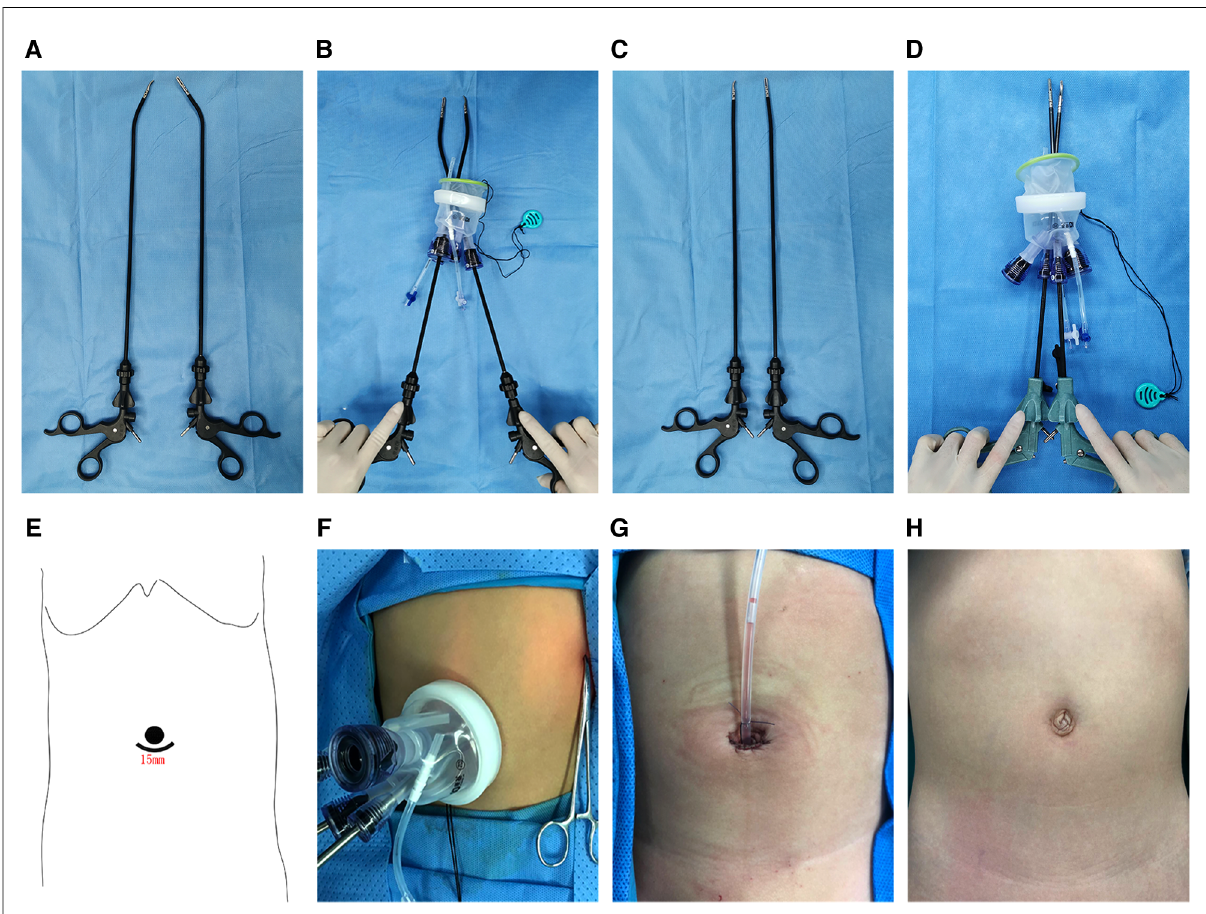
FIGURE 3 Surgical instrument system and incision design. ( A ) The parallel distribution of curved surgical instruments. ( B ) The crossover distribution of curved surgical instruments. ( C ) The parallel distribution of straight surgical instruments. ( D ) The crossover distribution of straight surgical instruments. ( E ) The surgical incision of SILS. ( F ) The SILS surgery port device. ( G ) Immediate postoperative image of the incision. ( H ) The appearance of the incision on 1 month after